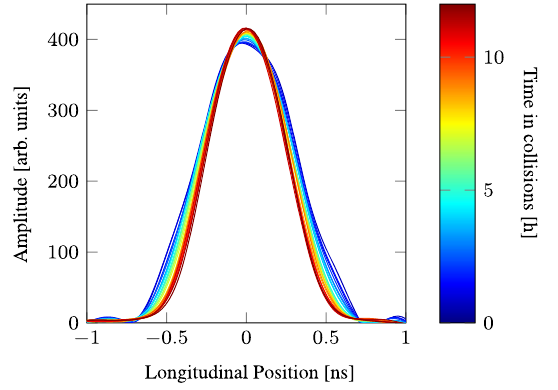
FIG. 4. Longitudinal profiles in LHC fill 4964 for beam 1, bunch 142 over 12 h in collisions, measured by a Wall Current Monitor pick-up sampled at 40 GS/s. Other bunches (including those in beam 2) behave similarly.